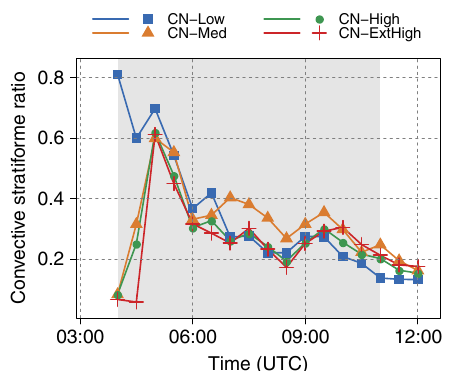
Figure 8. Ratio between total convective and stratiform precipita- tion produced by the MCS as a function of time for the CN-Low (blue), CN-Med (marigold), CN-High (green) and CN-ExtHigh (red) experiments.